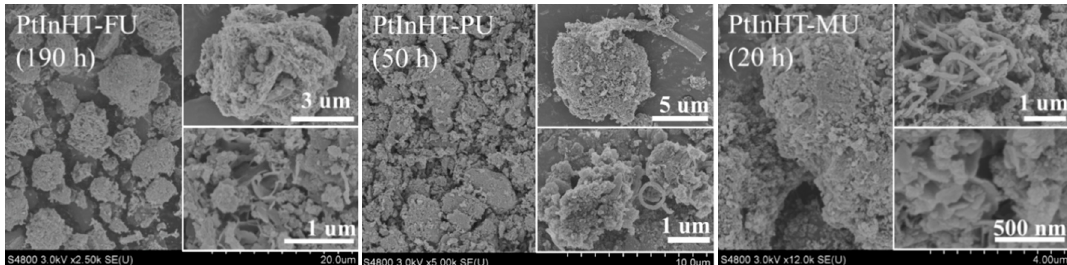
ff erent reaction Figure 8. SEM images of used catalysts with different reaction time. Figure 8. SEM images of used catalysts with di Figure 8. SEM images of used catalysts with different reaction time.